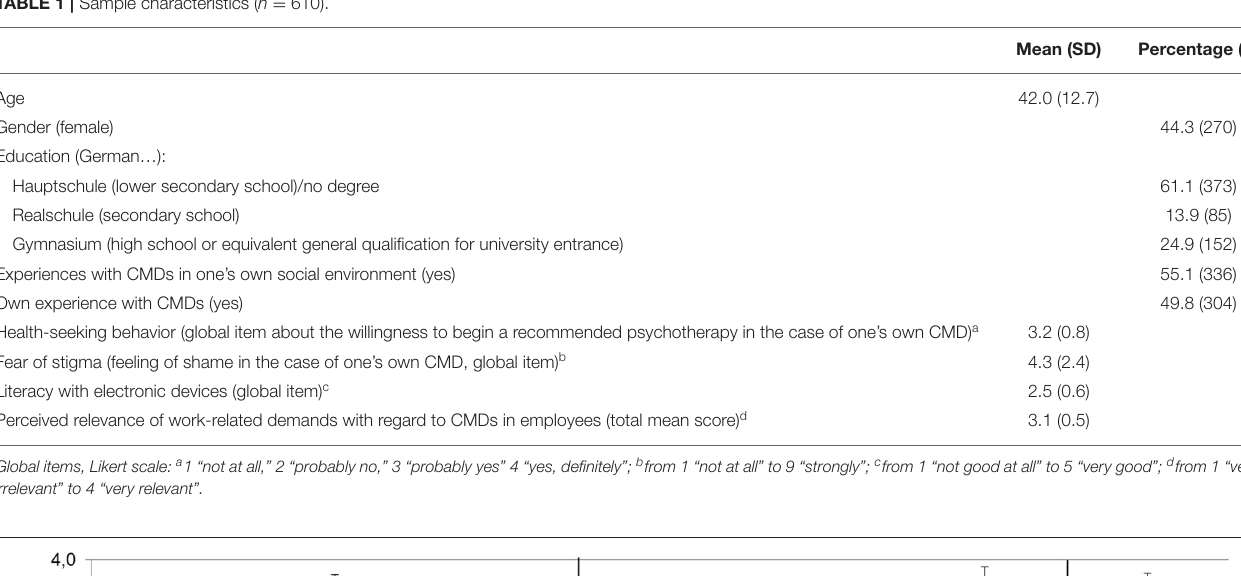
TABLE 1 | Sample characteristics ( n = 610).